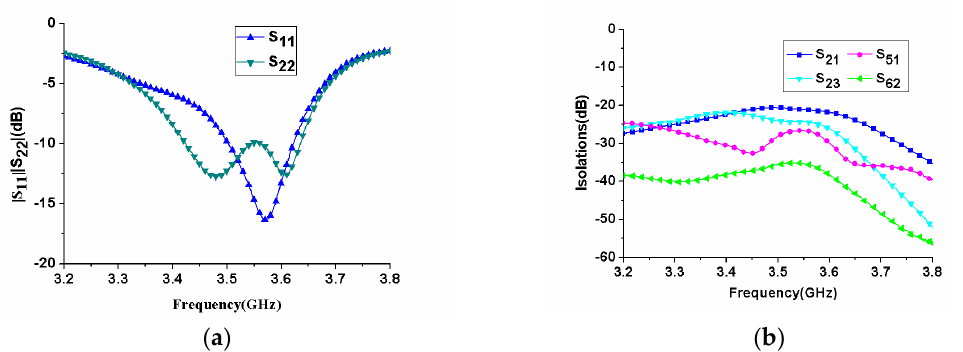
Figure 11. Measured S-parameters of the fabricated MIMO antenna array. ( a ) reflection coefficients; ( b ) isolations.